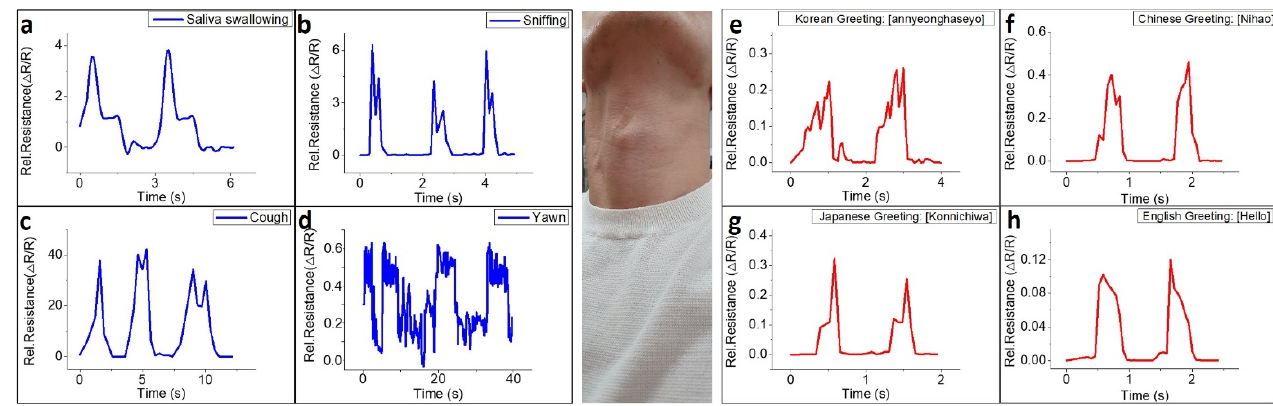
Figure 5. Electrical signal records for subtle oscillations associated with the human vocal cord; the corresponding time dependent electrical signals of ( a ) swallowing salvia, ( b ) sniffing, ( c ) coughing, ( d ) yawning, and phonation of words four greetings: ( e ) Korean, ( f ) Chinese, ( g ) Japanese, and ( h ) English.